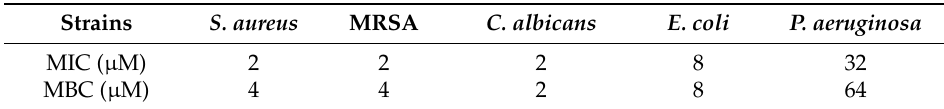
Table 1. Minimum inhibitory concentrations (MICs) and minimum bactericidal concentrations (MBCs) of PSN-PC. Strains